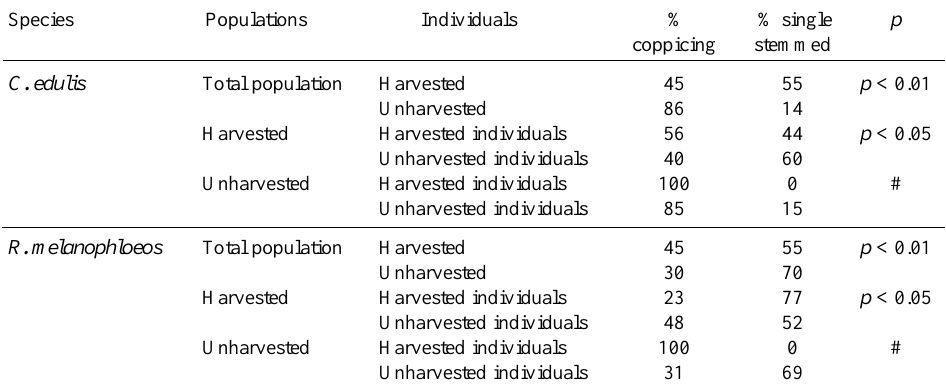
Proportion of harvested and unharvested Catha edulis and Rapanea melanophloeos populations that were coppicing or single stemmed (# statistical analysis not performed as n=0 in one or more